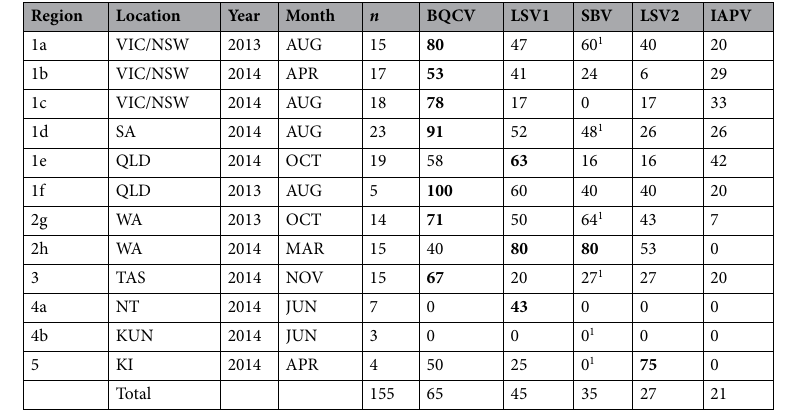
Table 1. Percentage prevalence of five honeybee viruses across Australia with the most prevalent virus in each region in bold. 1 Brood sample positive for SBV.